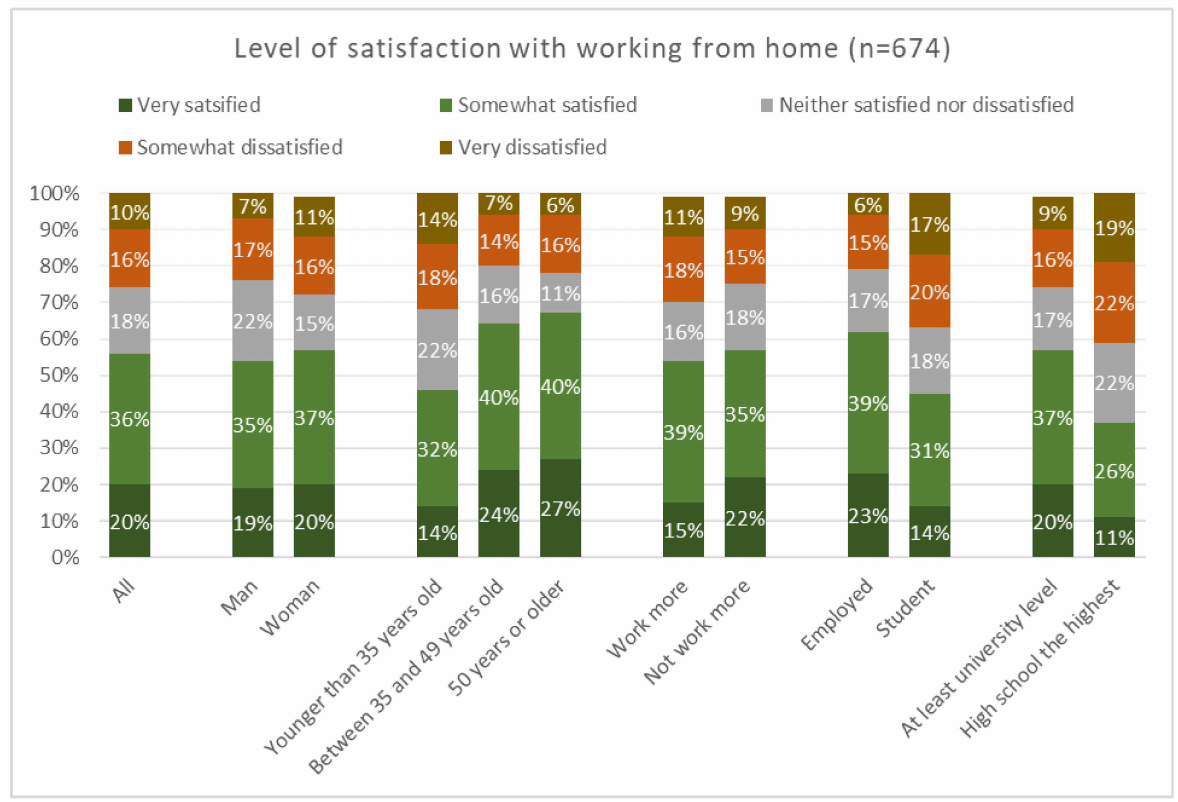
Figure 3. Level of satisfaction with working from